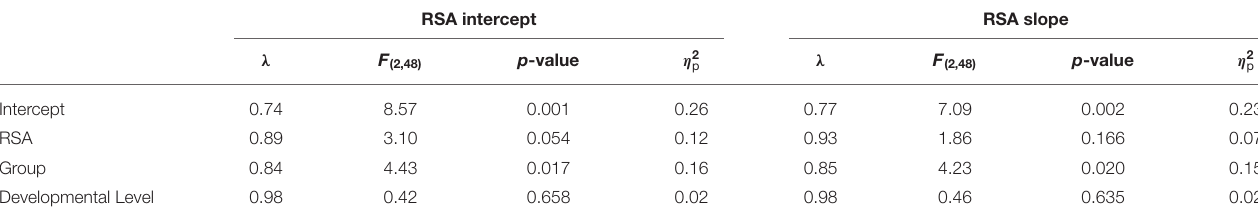
TABLE 5 | Multivariate general linear model results for RSA intercept and RSA slope at 24 months predicting later ASD and anxiety